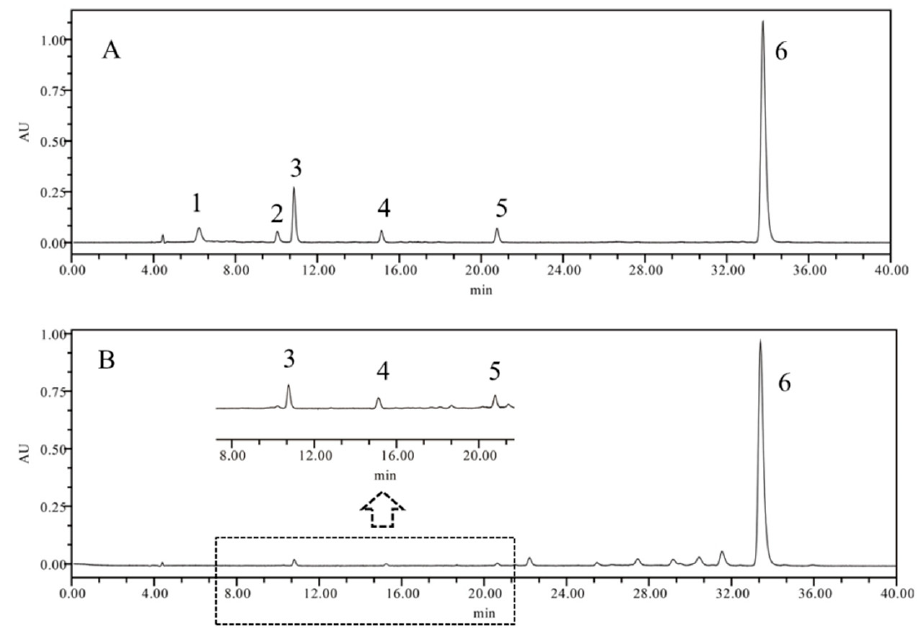
Figure 1. HPLC chromatogram of carotenoids in fruits of Lycium barbarum (( A ) chromatogram of mixed standards solution; ( B ) chromatogram of sample solution (sample no. 5 from Zhongwei of Ningxia); 1. neoxanthin, 2. lutein, 3. zeaxanthin, 4. β -cryptoflavin, 5. β -carotene, 6. zeaxanthin dipalmitate).